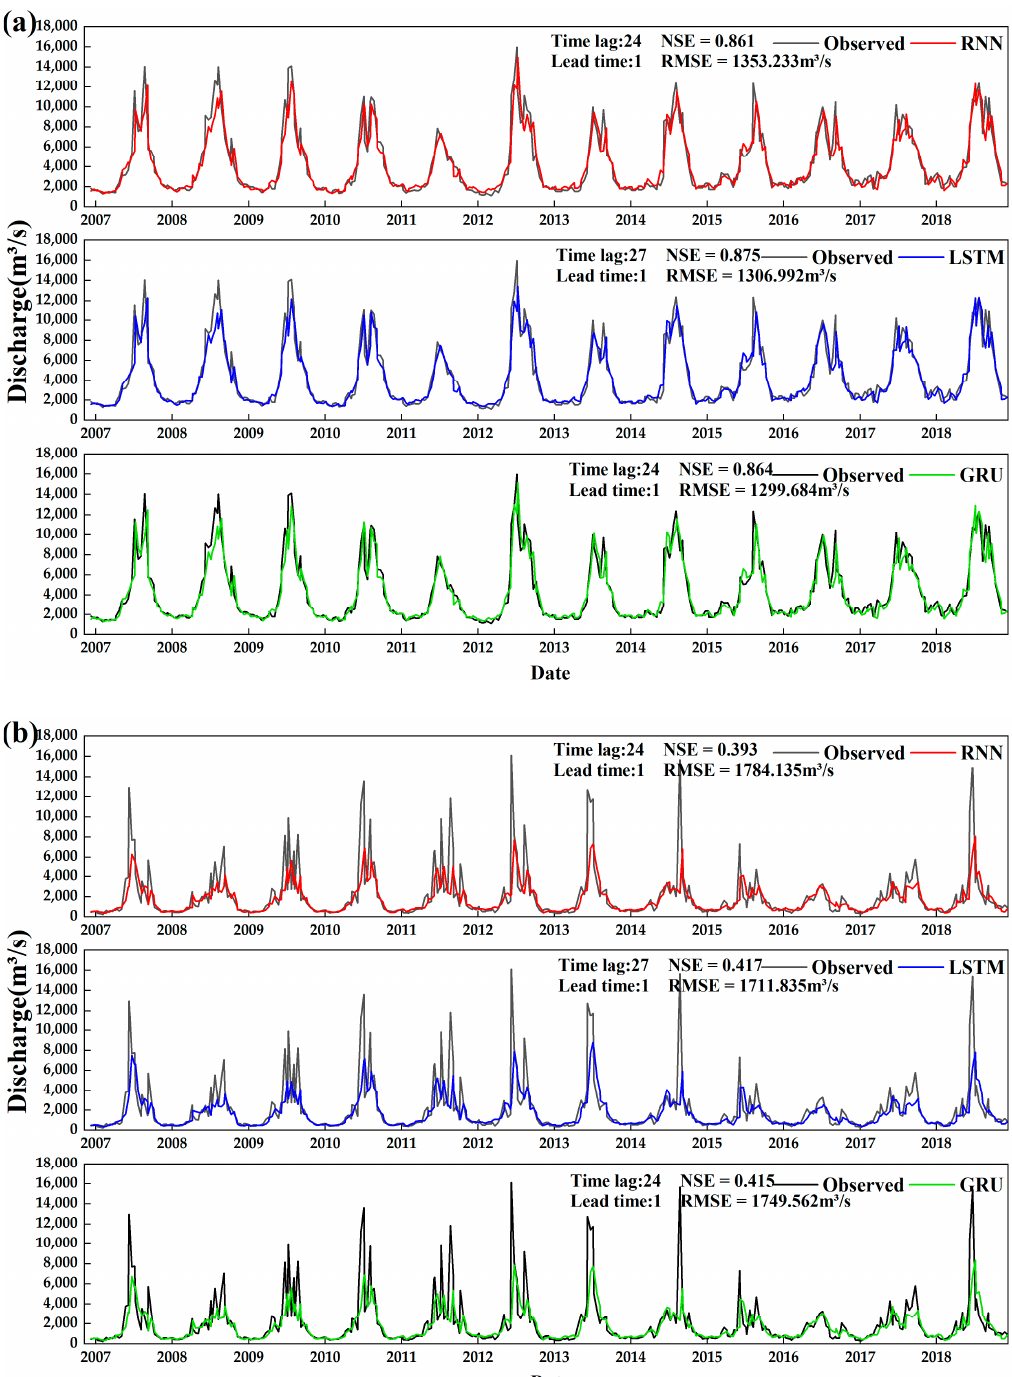
Figure 10. Observed and predicted discharge from RNN, LSTM, and GRU models at optimal time-lag and lead time at ten-day scale in ( a ) Pingshan and ( b ) Beibei.